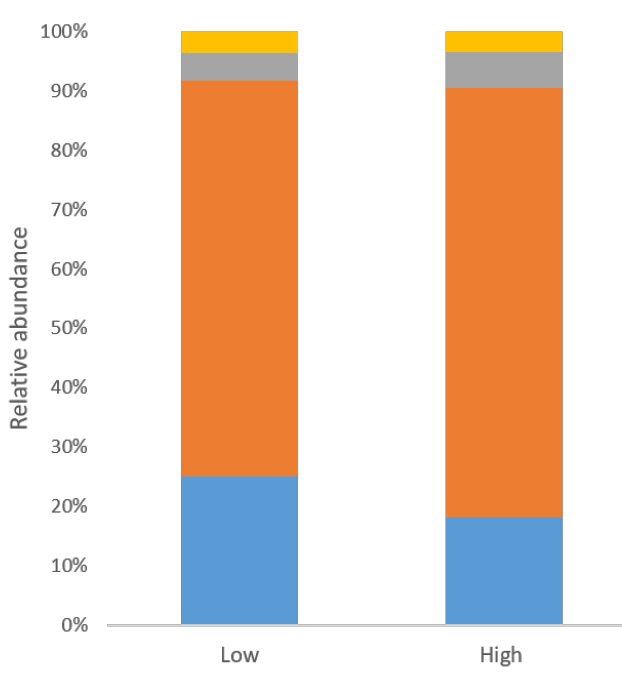
Figure 3. Alpha diversity analysis. Boxplots representing variations in alpha diversity in the rumen fluid: high (red) and low (green) emitters respectively. Alpha diversity metrics include observed OTUs, Evenness, and Shannon indexes are for both bacteria and archaea. High n = 7, Low n = 7.